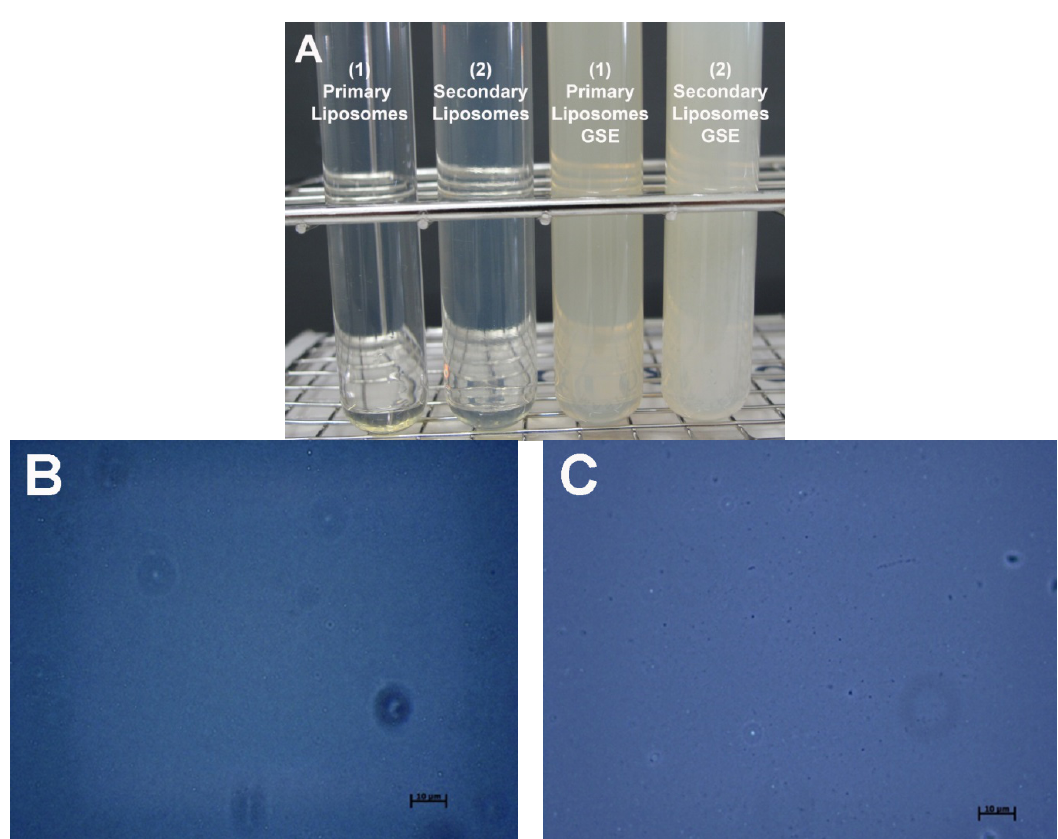
Figure 1. ( A ) Photographic images of (1) primary liposomes (1 w / w % lecithin) and (2) chitosan-coated secondary liposomes with and without incorporated grape seed extract (GSE) (0.1 w / w % GSE, 1 w / w % lecithin, 0.1 w / w % chitosan); ( B ) optical microscope images of primary liposomes containing GSE and ( C ) of secondary liposomes containing GSE. Magnification: 1000× (scale bar: 10 μ